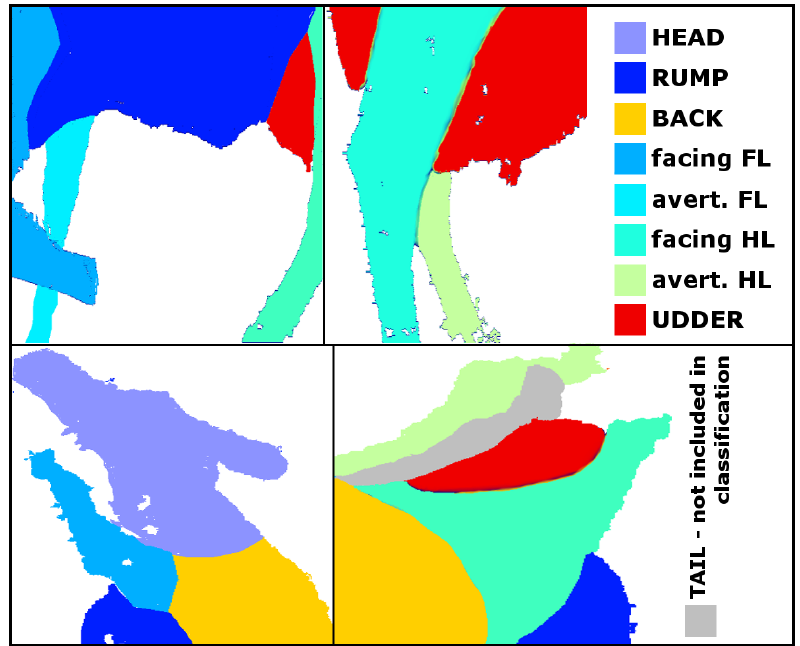
Figure 2. Example images from camera positions ‘S’ (top row) as well as ‘U’ and ‘N’ (bottom row). The image background was whitened and the result of labelling the images with the polygon drawer were displayed. Body parts were colored differently.